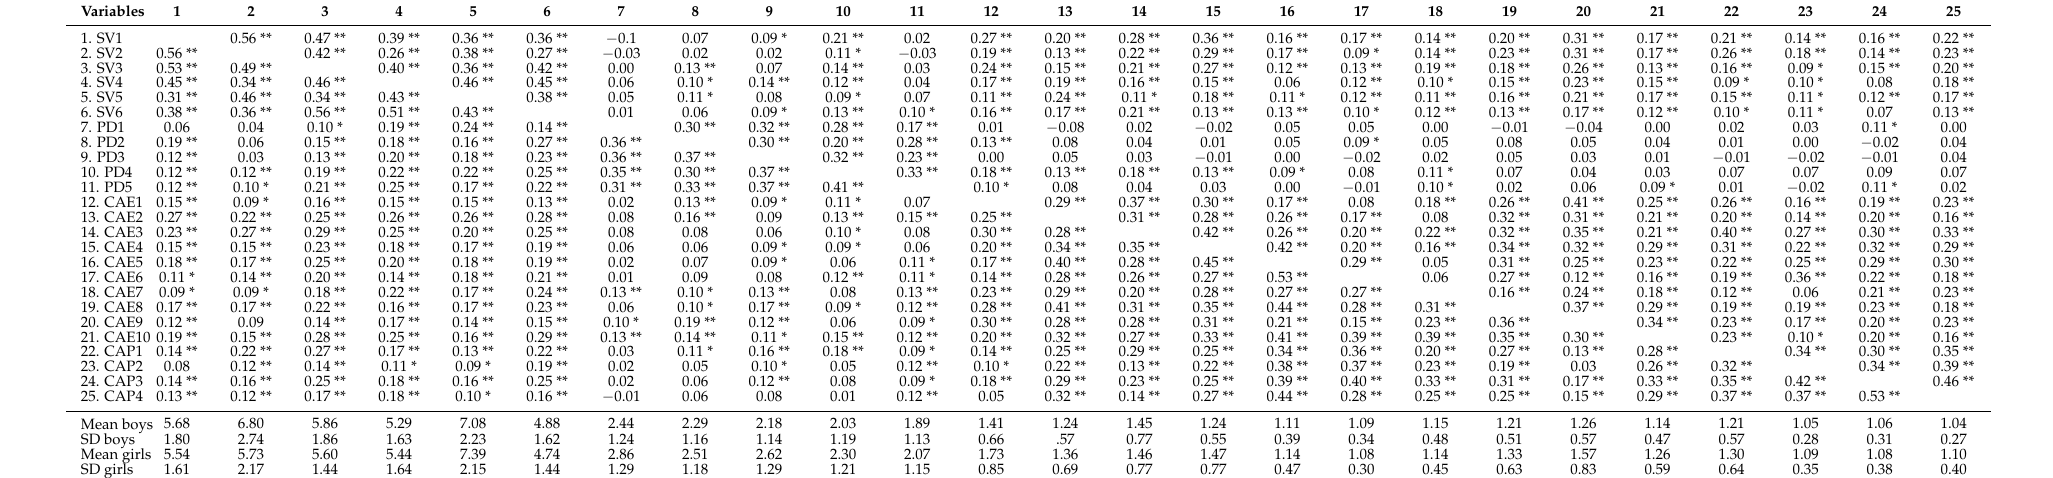
Table A1. Spearman correlations and descriptive statistics for observable variables for girls (top right) and boys (bottom left). Complete